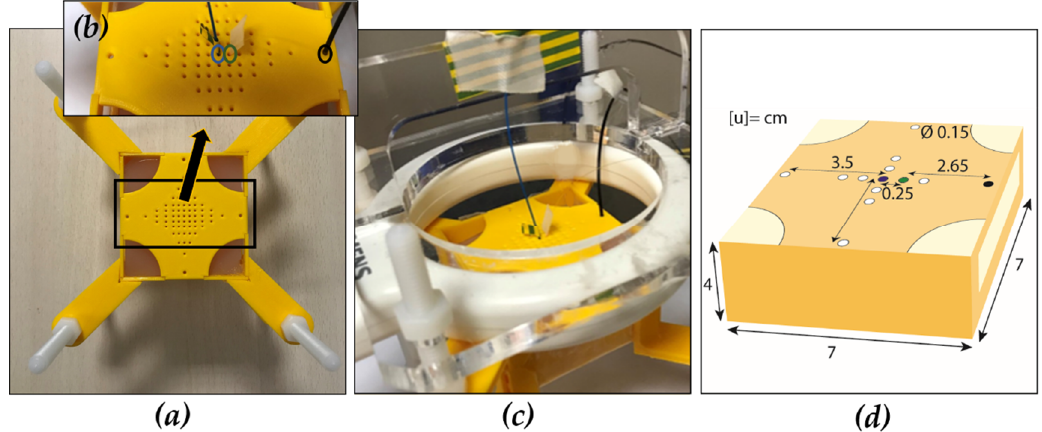
Figure 2. ( a ) Top view of 3D printed box (7 × 7 × 4 cm 3 ) with agar gel phantom inside. Box tap pattern aimed at controlling the relative distance among the laser optical applicator and the FBGs array is showed. Laser optical applicator (blue circle), FBGs array (green circle), and fluoroptic sensor (black circle) arrangement in the box ( b ), ( c ) and their relative distances ( d ). The FBGs hole center (green spot in ( d )) is at 0.25 cm from the central hole center (blue spot in ( d )) and 2.65 cm from the center of the Luxtron sensor hole (black spot in ( d )).